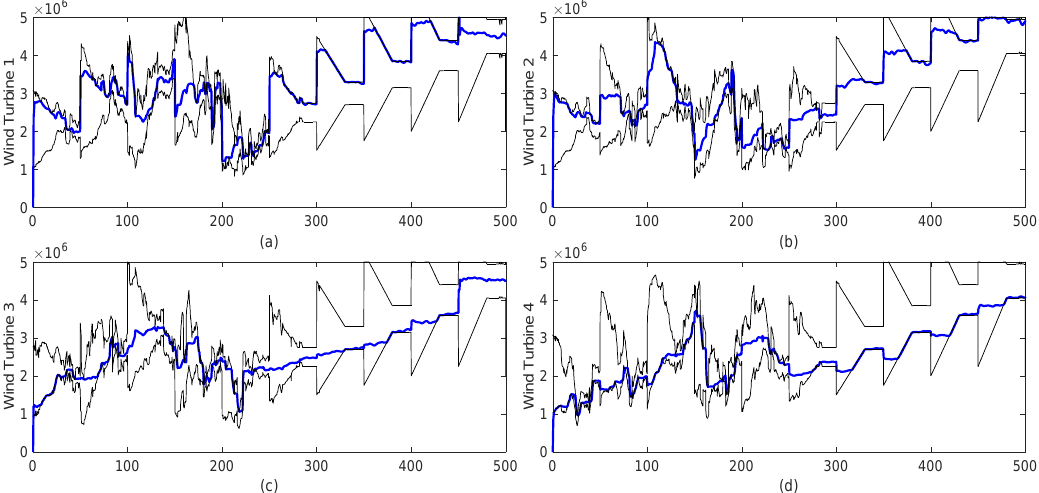
Figure 7. Four-units cluster robustness test—the active power output under the proposed controller for each wind turbine, sub-figures a, b, c, d are the active power output and the constraints under the proposed strategy for wind turbine 1, 2, 3, 4 respectively.